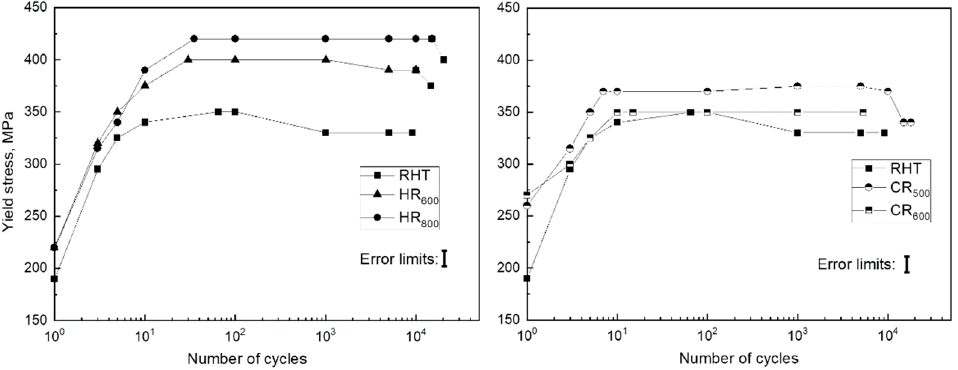
Figure 4. Evolution of the dislocation yield stress with the increasing number of cycles for the Fe ‐ 30Mn ‐ 5Si alloy after various treatment regimes.